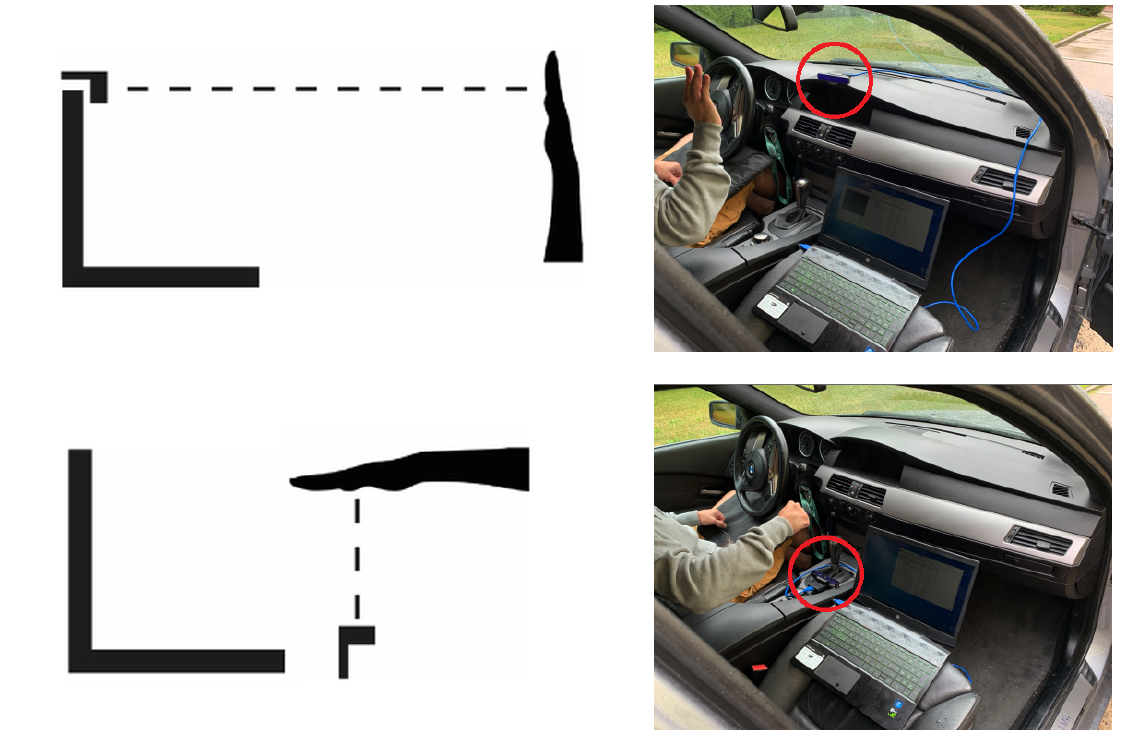
Figure 4. The sensor location: in the center dashboard ( top ), near the armrest and gear shift ( bottom